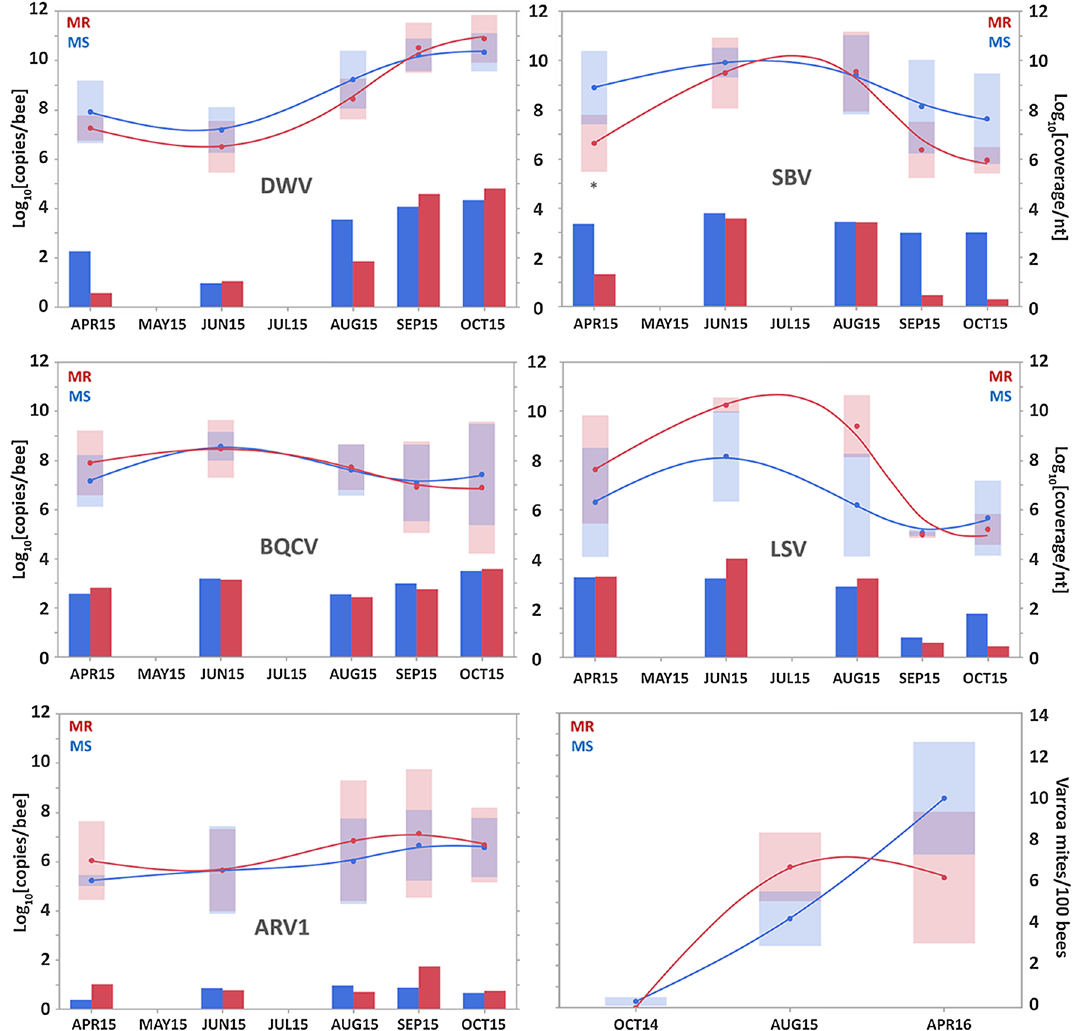
Figure 4. Virus titre distribution. Virus titres in adult bees from April–October 2015 season for colonies in the MR and MS honeybee colonies, as determined by RT-qPCR (line drawings, averages and confidence intervals) and RNA sequencing (histograms). Asterisks indicate that the virus titre difference between the MR and MS populations at that sampling occasion was significant at P < 0.05, as determined by Welch’s t-test. The RT-qPCR titres are marked on the primary Y-axis (left) while the genome equivalents of the read-count data are marked in the secondary Y-axis (right). The sixth panel shows the development of the varroa phoretic infestation rates of the MR and MS colonies between October 2014 and April 2016, together with the standard virus (DWV) increased by two (MS colonies) and three (MR colonies) orders of magnitude during the sea- son, peaking in October. Apis rhabdovirus-1 (ARV-1) also increased throughout the season, by about 1 order of magnitude for both the MS and MR colonies, peaking in September. Sacbrood virus (SBV) and Lake Sinai virus (LSV) both had broad peaks during summer. SBV decreased by between one (MS colonies) and three (MR colonies) orders of magnitude by the end of autumn, while LSV decreased by between one (MS colonies) and four (MR colonies) orders of magnitude from a high in June to a low in September. Black queen cell virus (BQCV) remained relatively uniform throughout the season, with a modest peak in June. The qPCR data is largely confirmed by the normalized read-count data (Fig. 4), especially the significantly lower SBV levels in the MR colonies during early spring and autumn (Supplementary Table 3). Also of interest is the slower increase in DWV titre development for the MR colonies between April and August. The final panel shows the development of the phoretic varroa infestation rate on adult bees from October 2014 to April 2016, which is consistent with how these rates develop in similar experiments with colonies from this varroa-surviving population 8,10,14–16 . The data for the other four time-points during 2015 was unfortunately lost. The panel is therefore mostly descriptive, rather than explanatory for trends in the 2015 metagenomic data. Virus phylogenetic analyses. The full genome consensus sequences of the five viruses for the two types of colonies at each sampling occasion were determined through RNA sequencing of pooled RNA samples. These